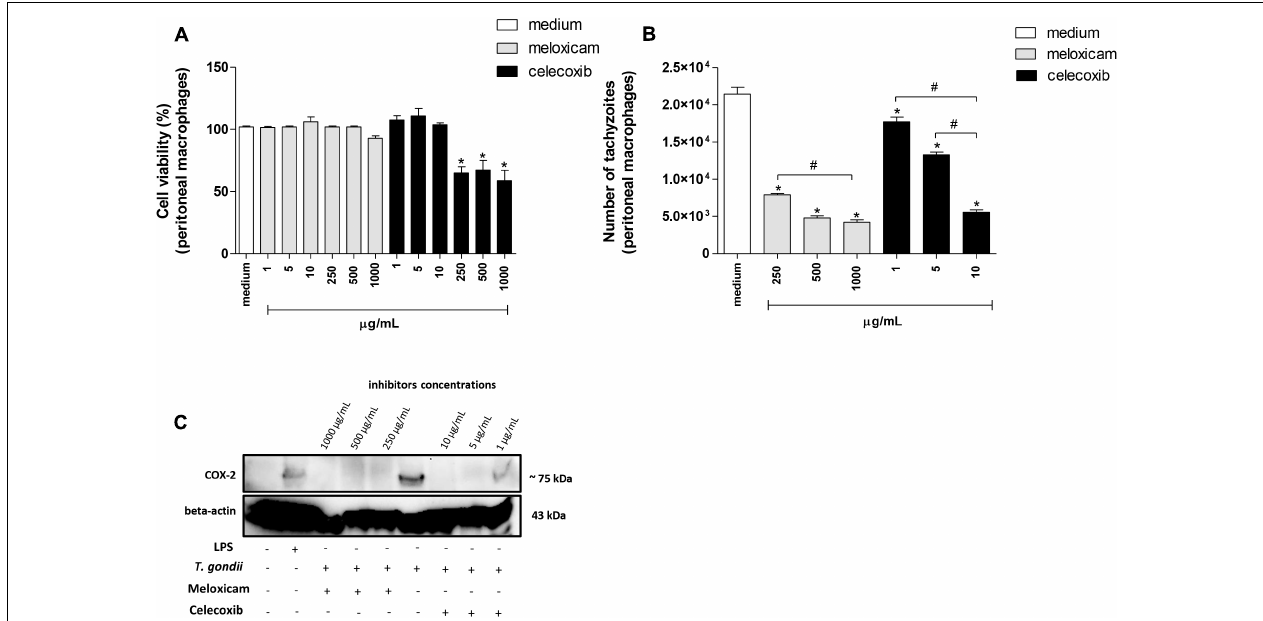
FIGURE 4 | Cell viability, number of tachyzoites and COX-2 expression in C. callosus -peritoneal macrophages treated with COX-2 inhibitors. Peritoneal macrophages were seeded in 96-well plates (1 × 10 5 cells/200 µ L) in RPMI medium at 37 ◦ C and 5% CO 2 . After 24 h, the cells were treated or untreated with meloxicam or celecoxib in several concentrations for an additional 24 h and submitted to MTT assay (A) . Data are expressed as percentage of viable cells (% cell viability) in comparison to untreated cells (100% of cell viability). Data are shown as mean ± SEM from two independents experiments with six replicates (A) . In parallel, peritoneal macrophages were seeded in 96-well plates (1 × 10 5 cells/200 µ L) for 24 h, infected with T. gondii tachyzoites (2F1 clone, RH strain), treated or untreated with meloxicam or celecoxib for additional 24 h and submitted to T. gondii intracellular proliferation assay by β -galactosidase colorimetric reaction (B) . Data are shown as mean ± SEM of the number of tachyzoites from three independents experiments with six replicates (B) . Differences between groups were analyzed by one-way ANOVA with the Bonferroni multiple comparison post hoc test. Significant differences in relation to untreated/uninfected (medium, A ) or untreated/infected cells (medium, B ) ( ∗ P < 0.05), and different concentrations of COX-2 inhibitors ( # P < 0.05). (C) Peritoneal macrophages (1 × 10 6 cells/2000 µ L in six-well plates) were infected or not and treated or not with meloxicam or celecoxib in RPMI medium during 24 h. As positive control, peritoneal macrophages were not infected and only treated with 1 µ g/mL LPS. Then, macrophages were lysed and submitted to Western blotting for COX-2 and beta-actin